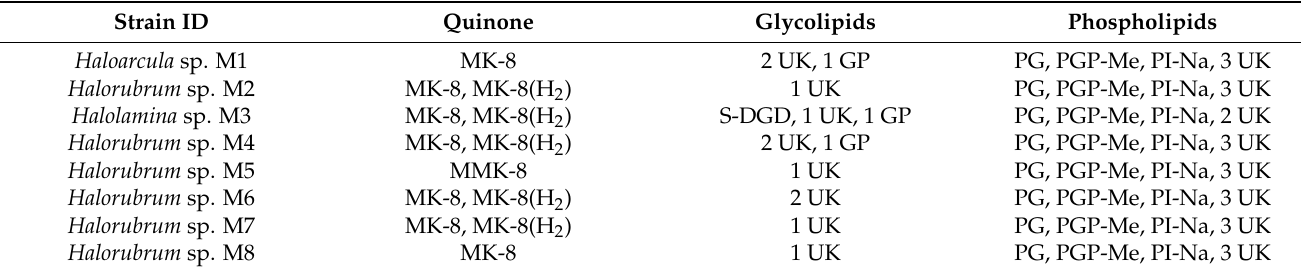
Table 2. The eight strains and their lipid content, MK-8 = menaquinone-8; UK = unknown lipid; GP = unidentified glycol-phospholipid; PG = polar phospholipids; PGP-Me = methylated polar phospholipids; PI-Na = phosphatidylinositol sodium salt; S-DGD = mannose-6-sulfate(1-2)-glucose glycerol diether.